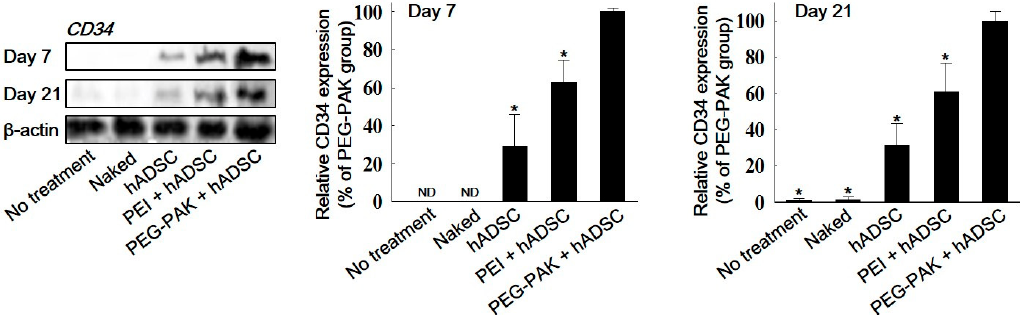
Figure 6. Western blot analysis and quantification of CD34 expression in ischemic hindlimb tissues at 7 and 21 days after treatment (* p < 0.05 compared with PEG-PAK + hADSC group).